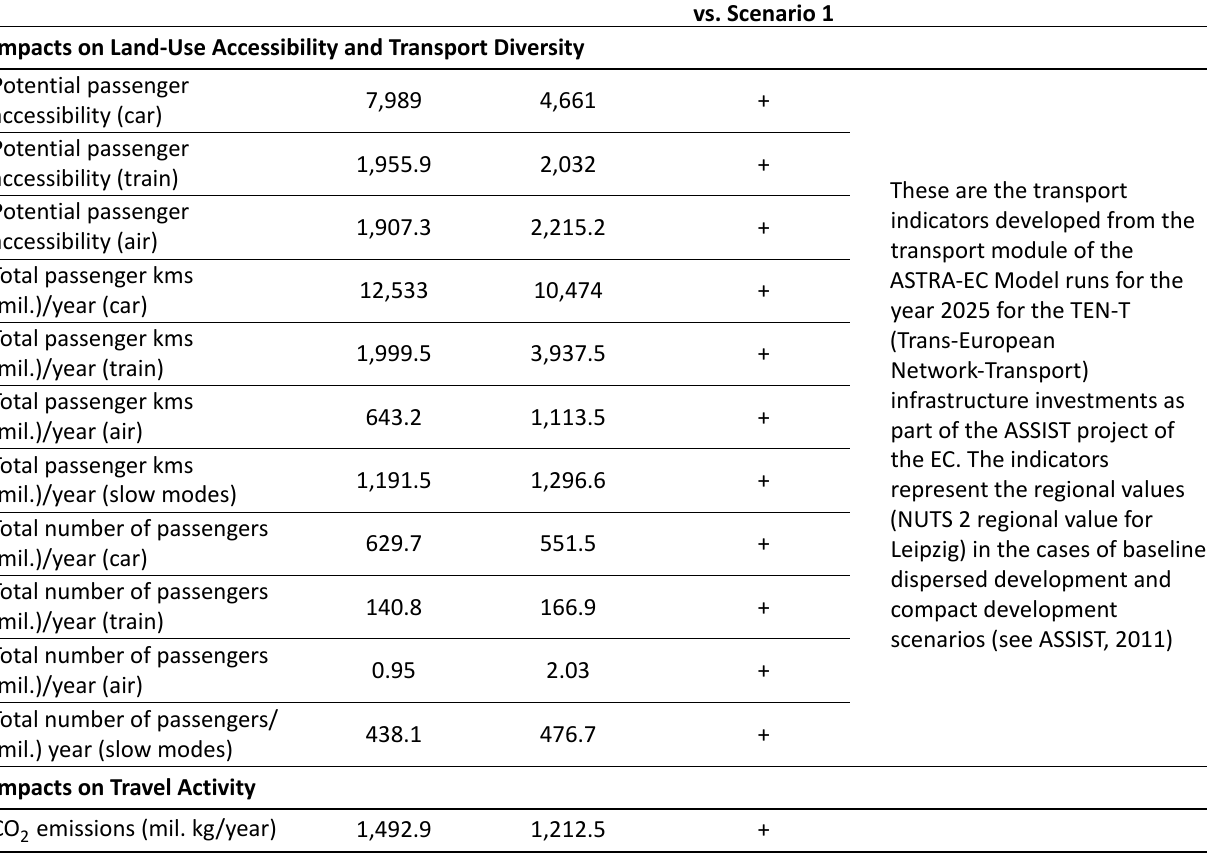
Table 7. Qualitative assessment of selected impacts and indicators for the Leipzig-Halle Region.